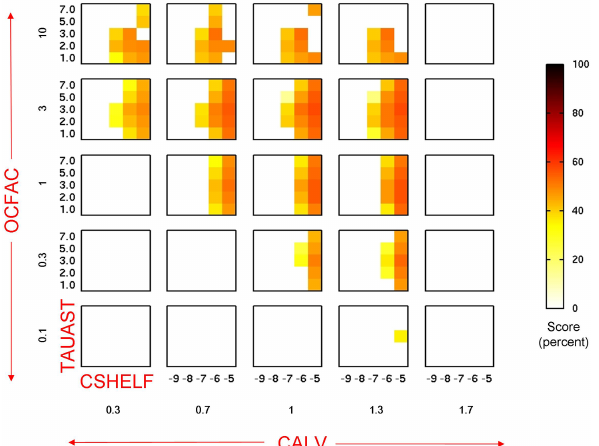
Figure 3. (Left) Ensemble-mean scores for individual parameter values, using the simple averaging method. The red triangle shows the mean, and whiskers show the 1-sigma standard deviations. (Right) Probability densities for individual parameters, using the advanced statistical techniques in Chang et al. (2016) extended as described in Sect.